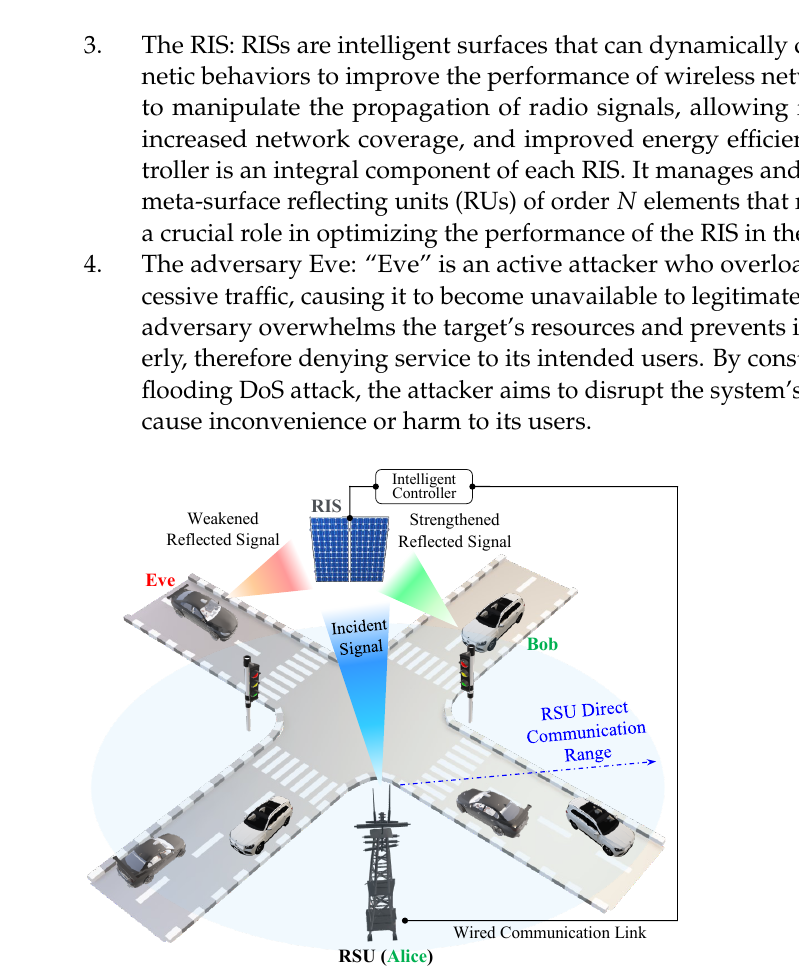
Figure 2. System